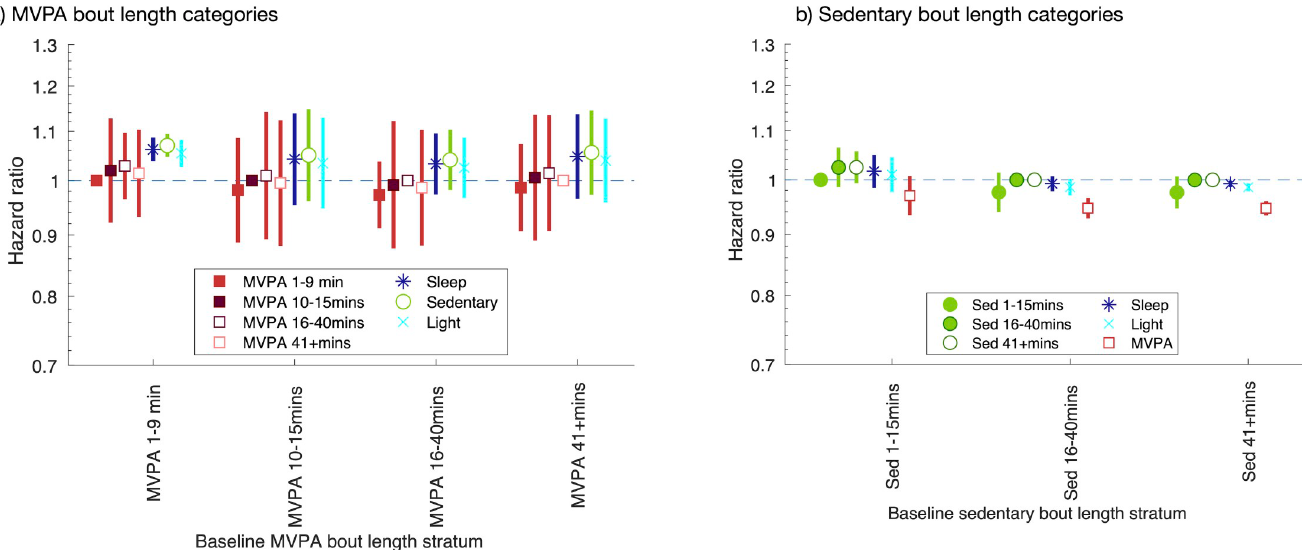
Fig 3. Associations of time spent in MVPA and sedentary bouts of given duration, with all-cause mortality. HR of spending 10 minutes more time on average per day in comparison activity category, coupled with spending 10 minutes less time in baseline activity category. Using the complete days data. Equivalent results using “other day” imputation approach are shown in S9 Fig. Covariates: age at accelerometer wear, sex, ethnicity, season, smoking, SEP (education, Townsend deprivation index, and income), BMI, and 3 indicators denoting whether the participant had had cardiovascular disease, cancer, or respiratory disease prior to accelerometer wear. Results shown are also provided in S5a and S6a Tables. BMI, body mass index; HR, hazard ratio; MVPA, moderate-vigorous physical activity; S AU : PleasedefineSEPintheabbreviationlistofFig 3 ifapplicable = appropriate : EP, socioeconomic position.